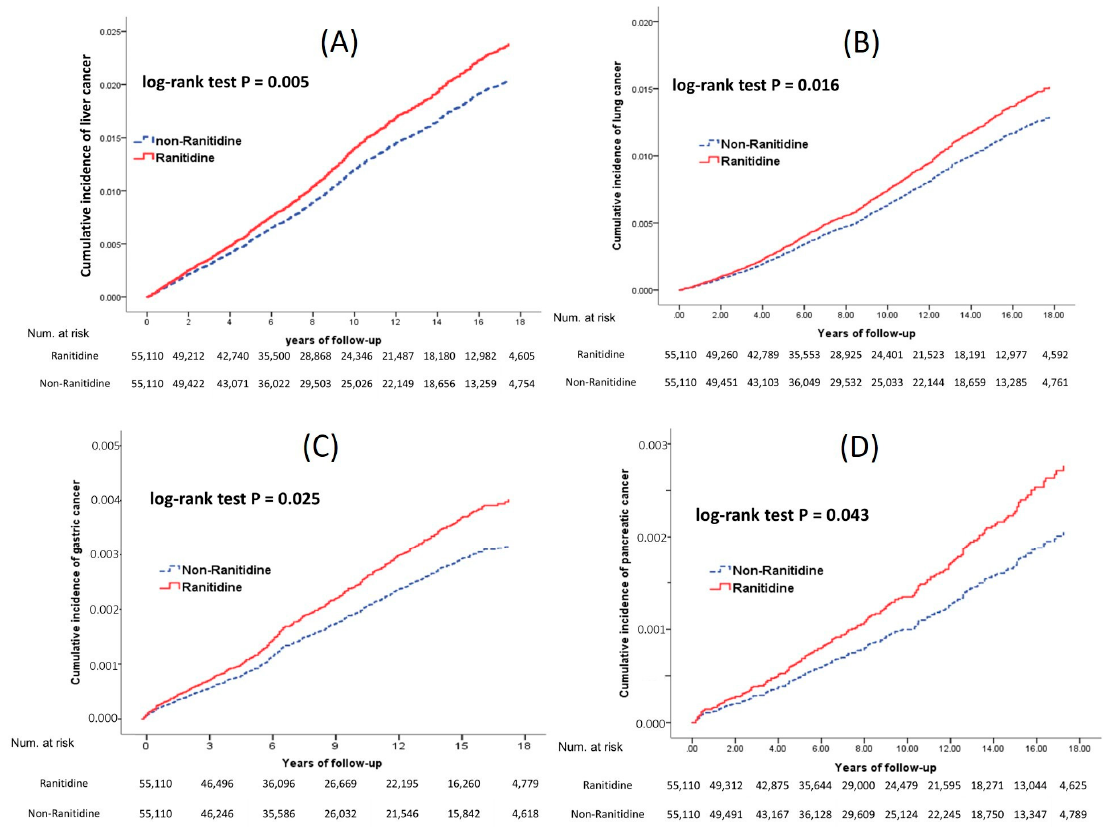
Figure 3. Cumulative incidences of single cancers after adjustment for competing risks. ( A ) Liver cancer, ( B ) lung cancer, ( C ) gastric cancer, and ( D ) pancreatic cancer.